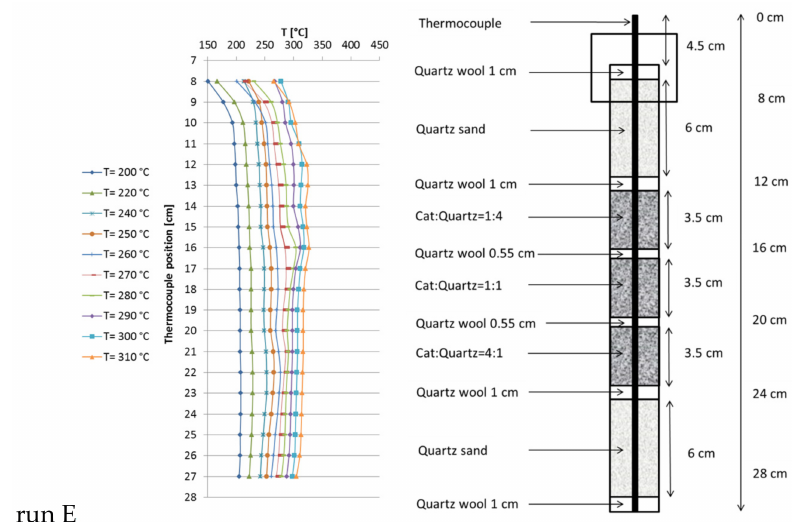
Figure 4. Recorded temperature profiles for methanation on 18Ni/Al 2 O 3 in a triple-bed reactor